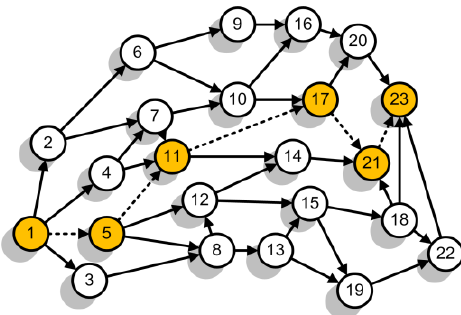
Figure 4. The optimal route of MGA-FSPP in